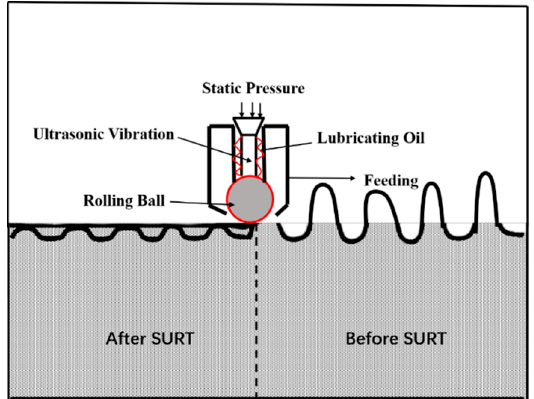
Figure 2. Schematic diagram of surface ultrasonic rolling machine.